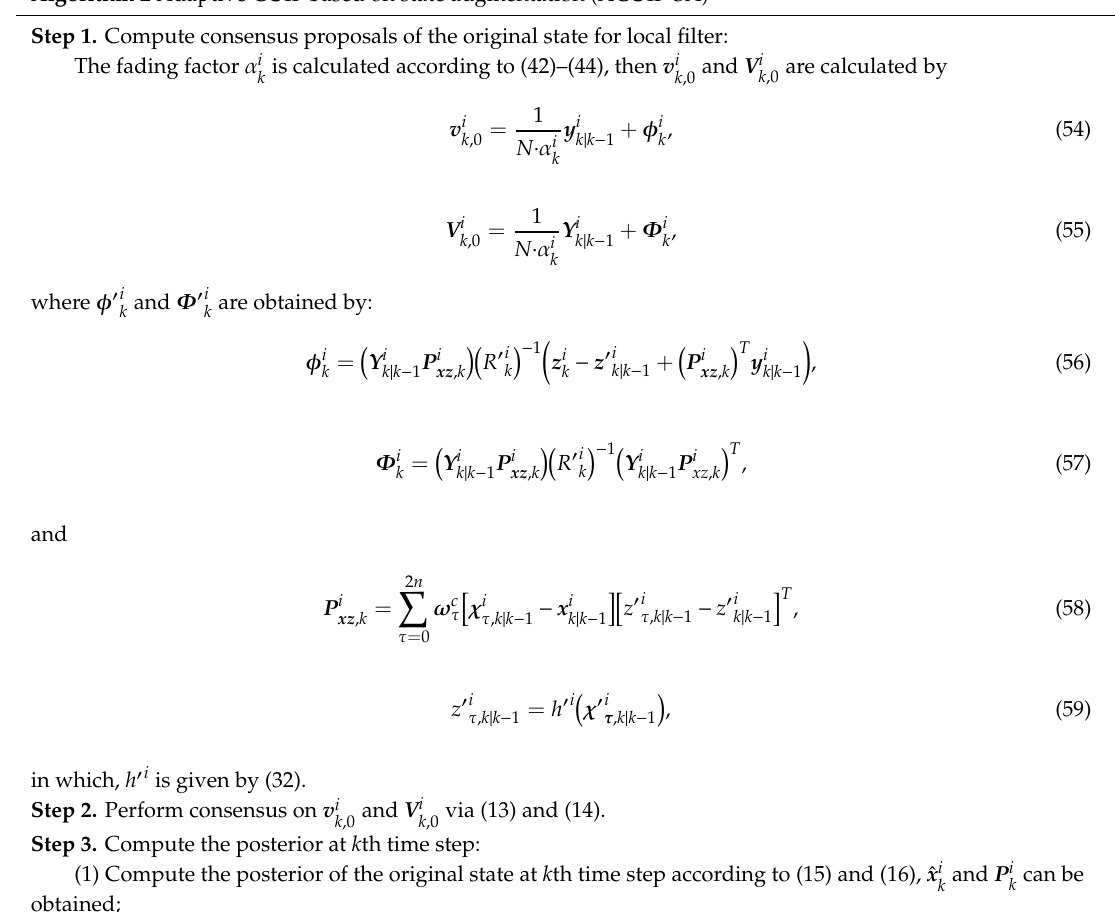
Algorithm 2 Adaptive CUIF based on state augmentation